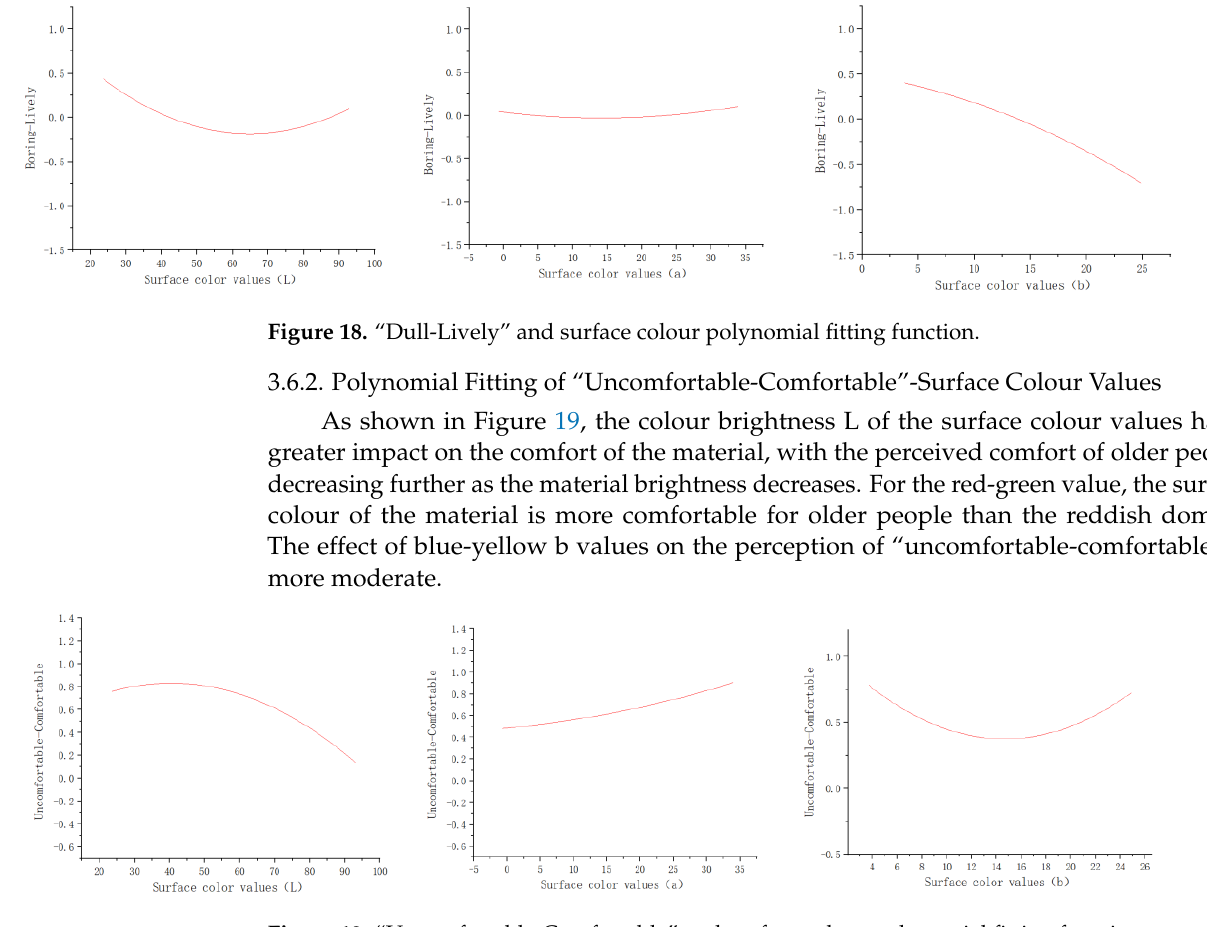
Figure 19. “Uncomfortable-Comfortable” and surface colour polynomial fitting